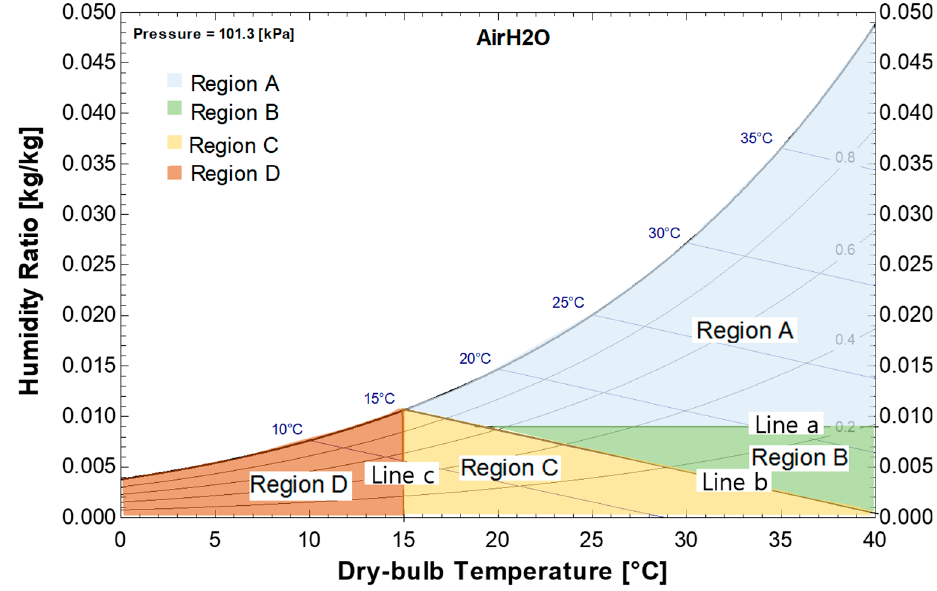
Figure 2. Four regions of psychrometric chart of HPLD-IDECOAS.